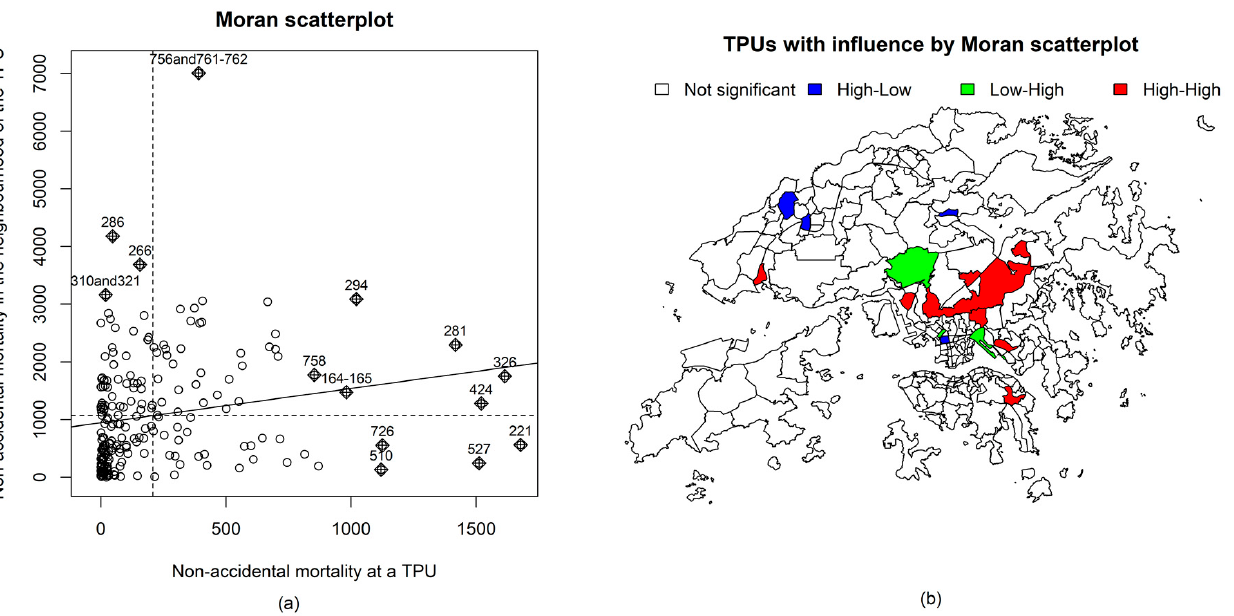
Figure 4. Spatial autocorrelation of non-accidental mortality in Hong Kong. Note: ( a ) the x-axis represents values in area i, whereas the y-axis represents the spatially weighted sums of values in the neighborhood of location i. Diamond-shaped points are areas whose local relationships influenced the slope of the straight line more than proportionately; the numbers above the diamonds are their TPU IDs. ( b ) High-High indicates that the mortality of the area and the average of its neighbors were higher than the global mean; High-Low indicates that the mortality of the area was higher than the global mean but that the average mortality of its neighbors was lower than the mean (Low-High indicates the